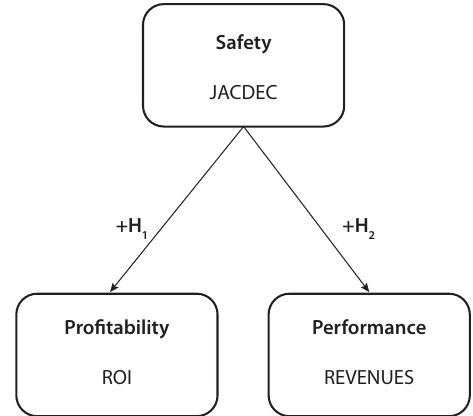
Figure 2. Conceptual model established through hypotheses (source: created by the